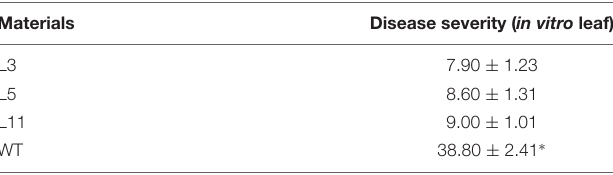
TABLE 1 | Disease severity of leaves of N. benthamiana seedlings infected with powdery mildew.